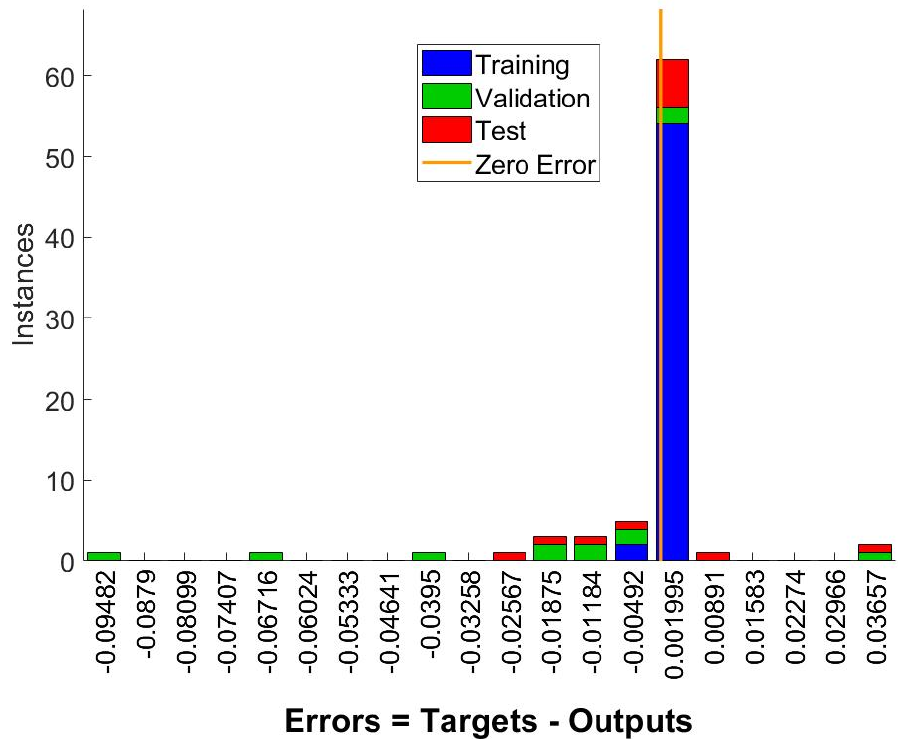
Figure 6. The error histogram showing the errors obtained from the training phase of the MLP neural network. Plane surface, K = 0 and R = 0